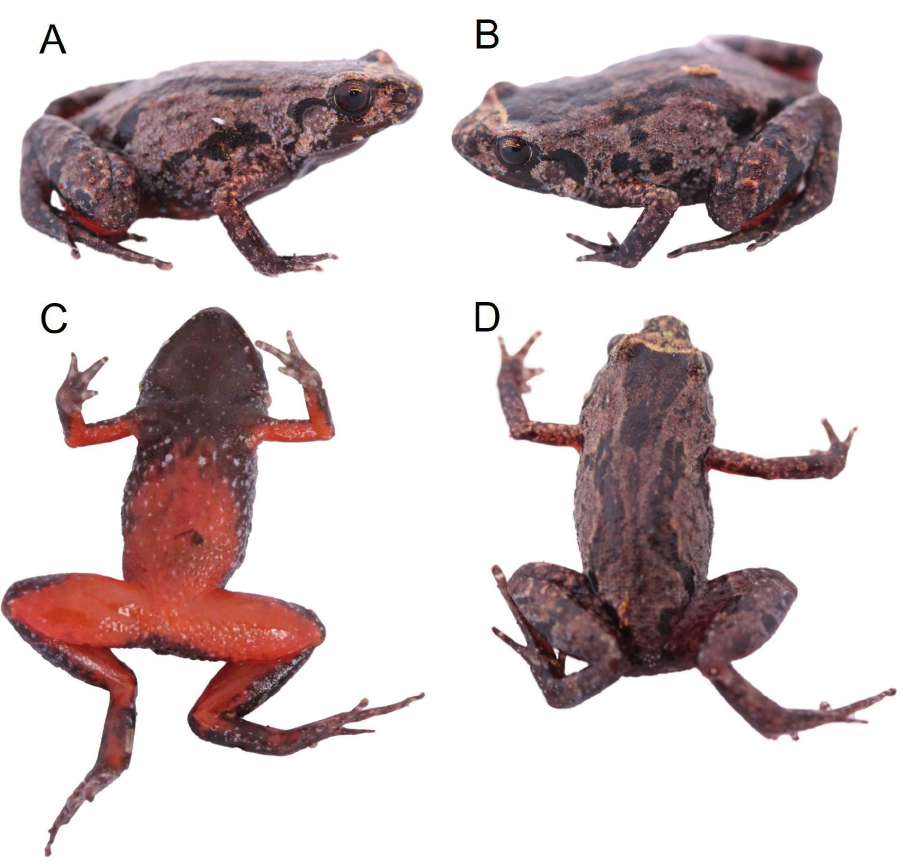
Figure 5. Images of the holotype ZSM 1/2022 (KAMU2) from Ambohitantely Special Reserve in life A, B dorsal lateral view C ventral view D dorsal Table 3. Morphological data of Stumpffia lynnae sp. nov. and Stumpffia kibomena (data for latter species from Glaw et al. (2015), and the proportion of the SVL (/SVL). Measurements (mm)